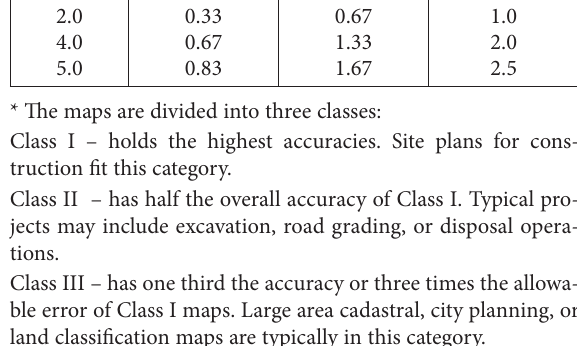
Table 6. ASPRS topographic elevation accuracy requirement for well-defined points ASPRS limiting root mean square Contour interval in meters